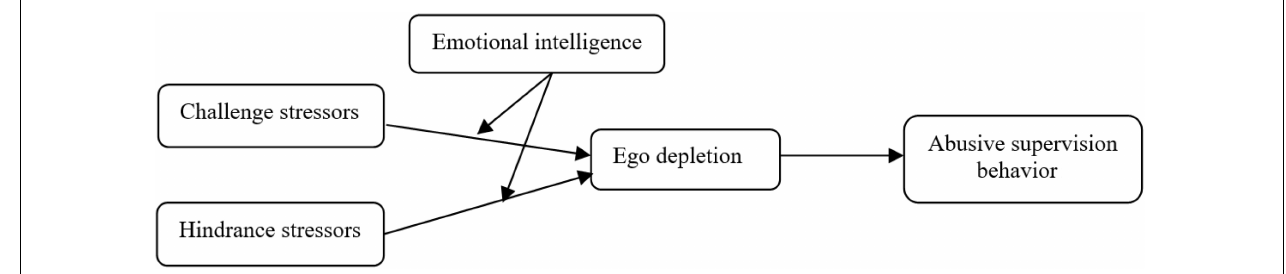
FIGURE 1 | The conceptual